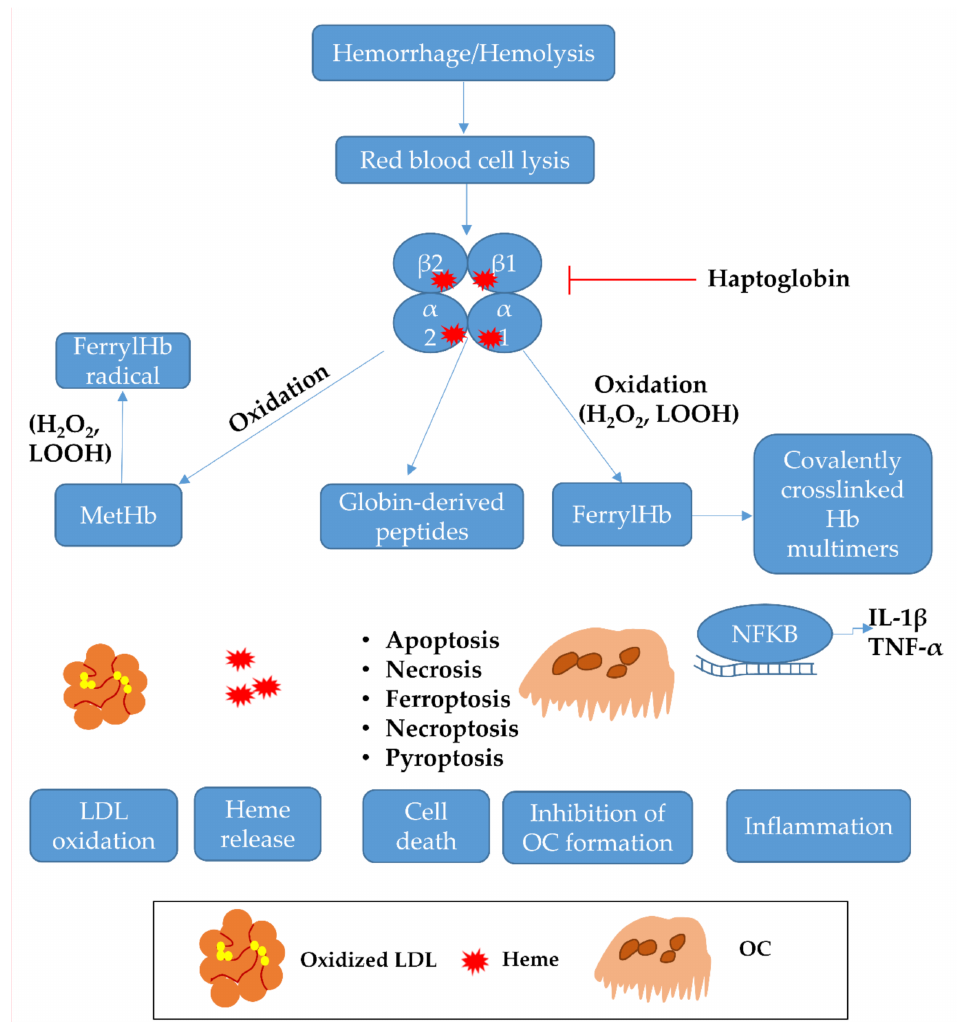
Figure 1. Hemoglobin-induced toxicity in hemolytic/hemorrhagic pathologies. Hemolysis and hemorrhage lead to the disruption of red blood cells with subsequent hemoglobin (Hb) release. Hb is rapidly scavenged by haptoglobin and taken up by macrophages via CD163 receptor. However, extensive hemolysis/hemorrhage rapidly overwhelms endogenous protective systems leading to Hb oxidation resulting in metHb, ferryl Hb, covalently crosslinked Hb multimers, or globin- derived peptides. Hb oxidation triggers low-density lipoprotein oxidation, cell death, inflammation, heme release, and inhibits oscteoclast formation. LDL: low-density lipoprotein; Hb: hemoglobin; NFKB: nuclear factor kappa-light-chain- enhancer of activated B cells IL-1 β : interleukin-1 β ; TNF- α : tumor necrosis factor- α ; OC: